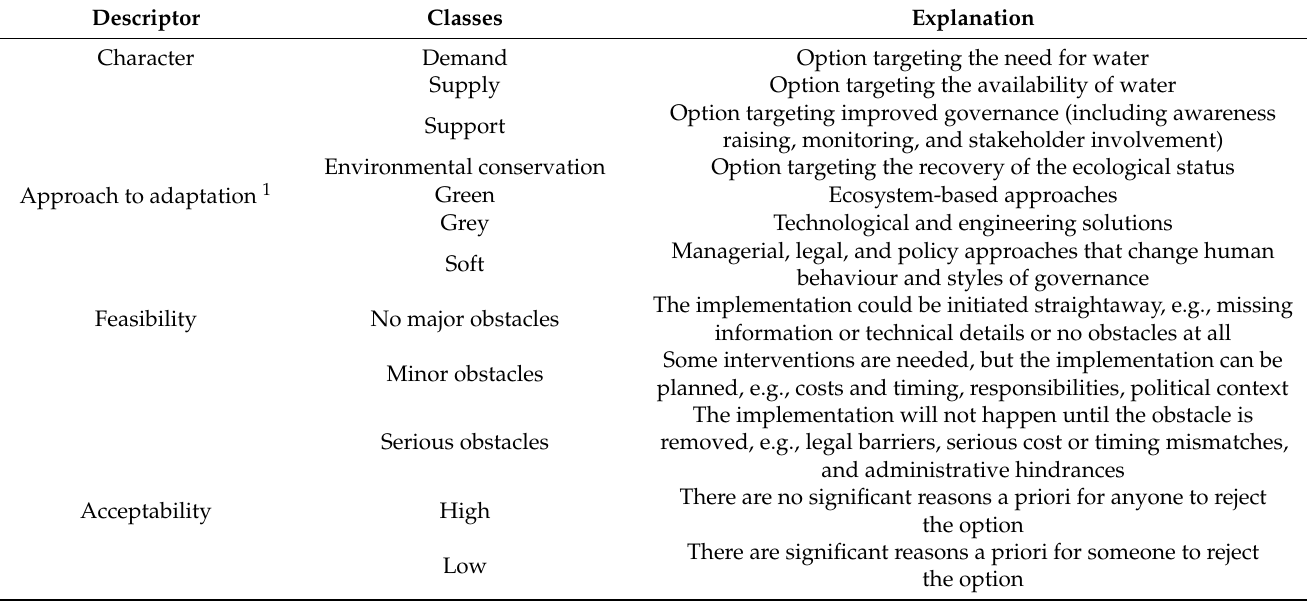
Table 2. Classes of each of the selected descriptors for the comparison of water management option (WMOs) characteristics in the four river